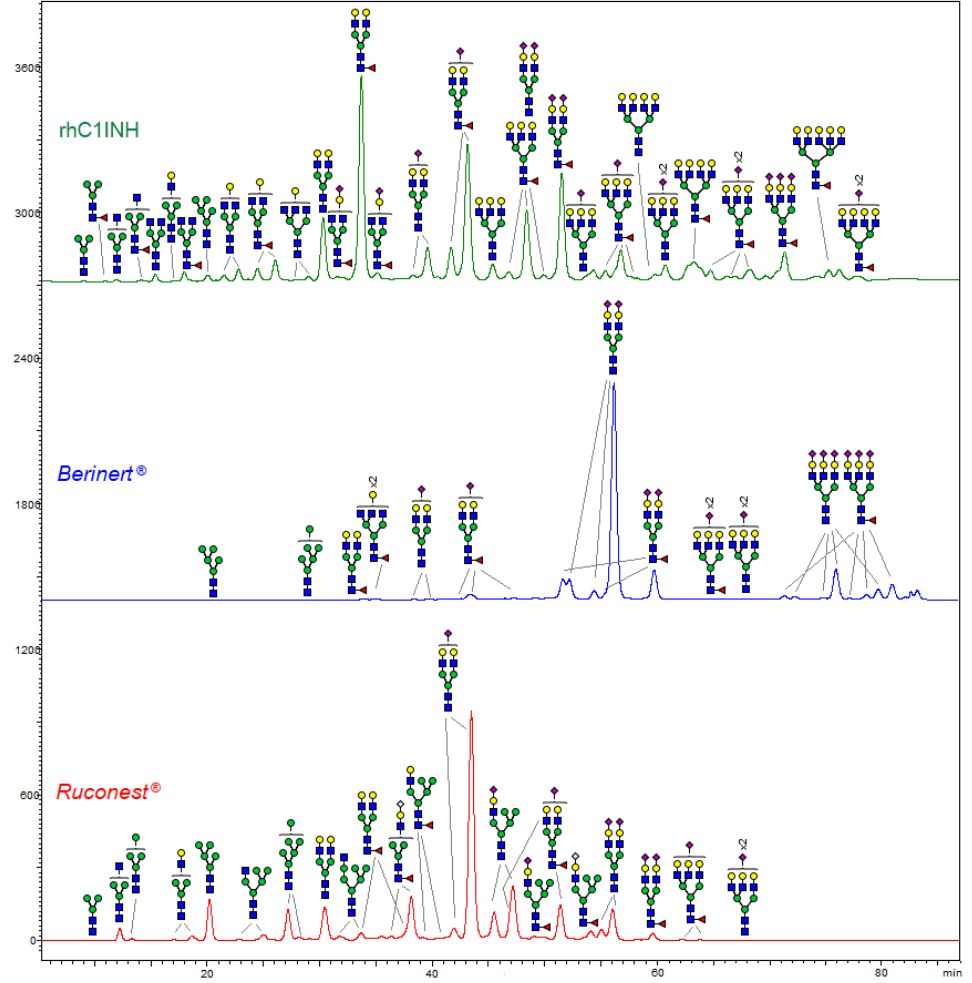
Figure 8. Comparative N-glycan profiles of rhC1INH, Berinert ® and Ruconest ® . Table 5. The relative area (%) of glycan peaks in rhC1INH based on HILIC data. N-Glycan Groups Content,